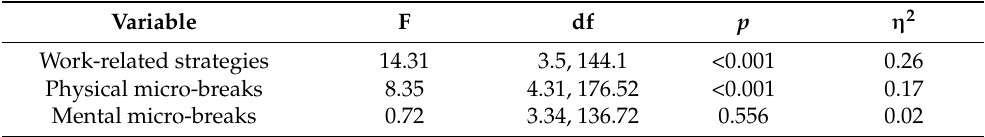
Table 4. Repeated measures ANOVA for the comparison of work-related strategies and micro- breaks (i.e., physical, mental) at the pre-test versus self-monitoring moments and post-test within the experimental group. Variable F df p η 2 Work-related strategies 14.31 3.5, 144.1 <0.001 0.26 Physical micro-breaks 8.35 4.31, 176.52 <0.001 0.17 Mental micro-breaks 0.72 3.34, 136.72 0.556